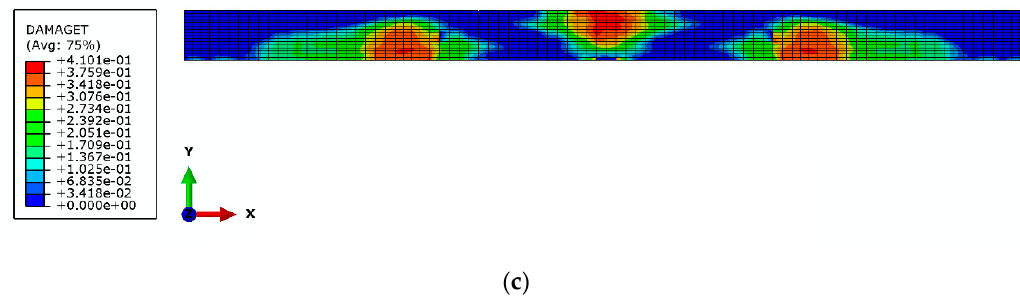
Figure 15. Damage distribution of beams obtained in Abaqus/Standard at the moment of failure for: ( a ) Beam B − 1; ( b ) Beam B − 2; ( c ) Beam B − 3.